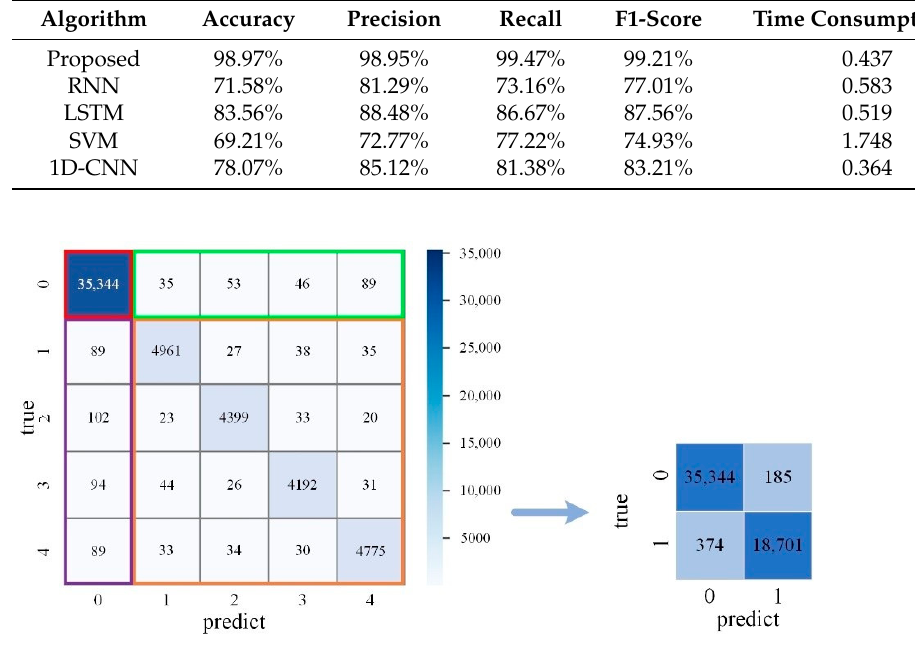
Table 4. Comparison of results between the proposed network and other algorithms.